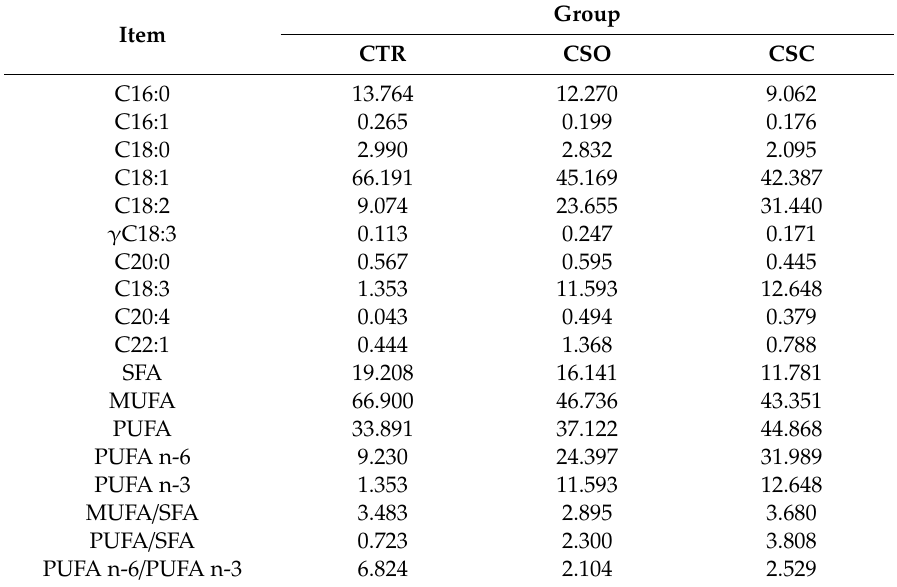
Table 2. Fatty acid profile of the feed mixtures used for broiler chickens (% of the sum of fatty acids).